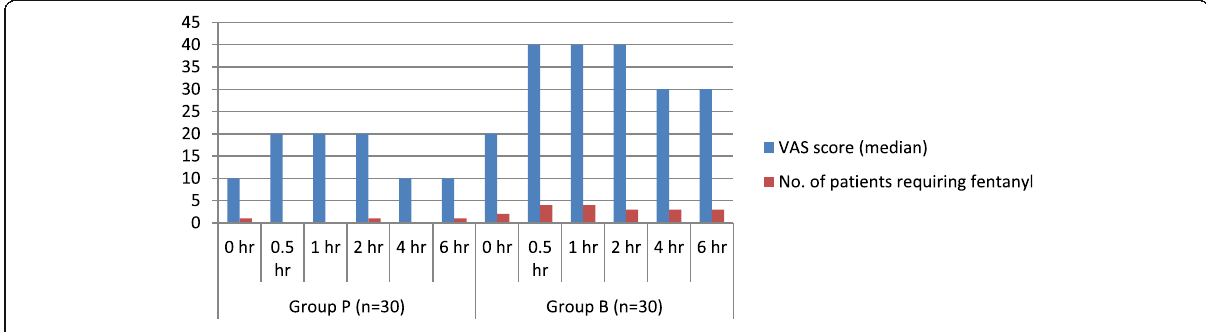
Fig. 4 VAS score (median) and number of patients requiring